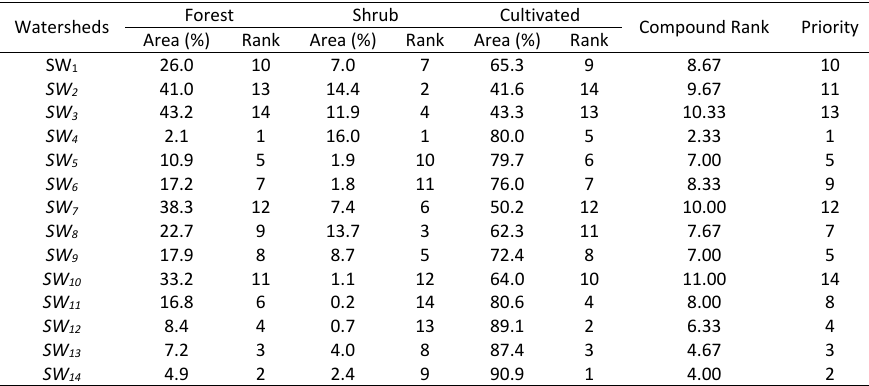
Table 7: Subwatershed priorities and ranks based on land use/land cover Forest Shrub Watersheds